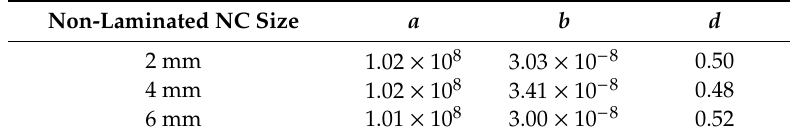
Table 5. Fitting coe ffi cients of non-laminated NC paper by our model.